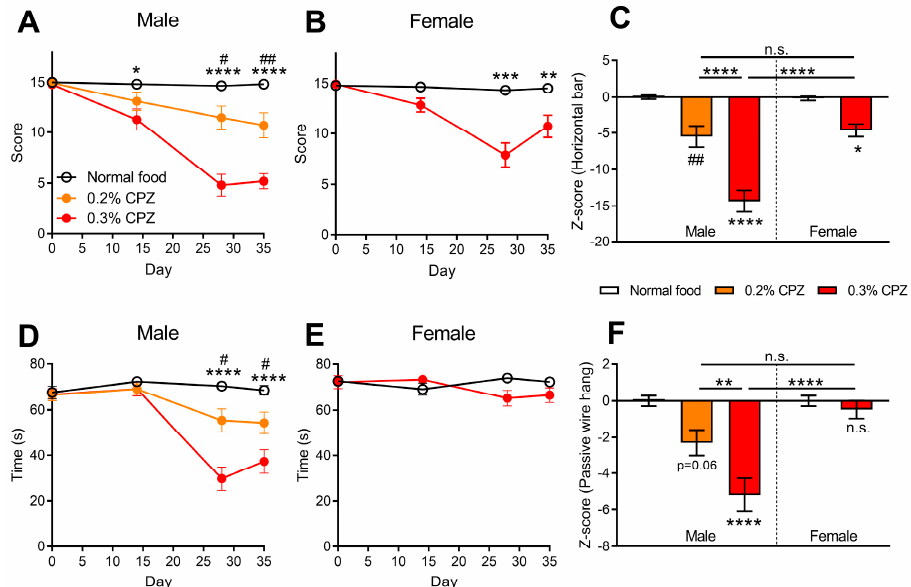
Figure 3. Cuprizone administration decreased motor coordination in C57BL/6J mice. Motor coordination was measured using the horizontal bar test in ( A ) male and ( B ) female mice. Cuprizone (CPZ) administration led to a decrease in the score in both sexes. ( C ) Z ‐ score analysis of the area under the curve data showed a sex and dose ‐ dependent effect, with the 0.3% cuprizone treatment in males decreasing the horizontal bar score more than the other cuprizone treatment groups. The passive wire hang test in ( D ) male and ( E ) female mice showed a deficit in cuprizone ‐ treated male mice but not female mice. ( F ) Z ‐ score analysis showed the 0.3% dose of cuprizone affected males greater than females. ( A , B , D , E ) Two ‐ way repeated ‐ measures ANOVA with Bonferroni post ‐ tests. ( C , F ) One ‐ way ANOVA with Bonferroni post ‐ tests. # p < 0.05, ## p < 0.01, for 0.2% cuprizone vs. normal food. * p < 0.05, ** p < 0.01, *** p < 0.001, **** p < 0.0001 for 0.3% cuprizone vs. normal food, or as indicated. Data presented as mean ± SEM. n = 12–18.